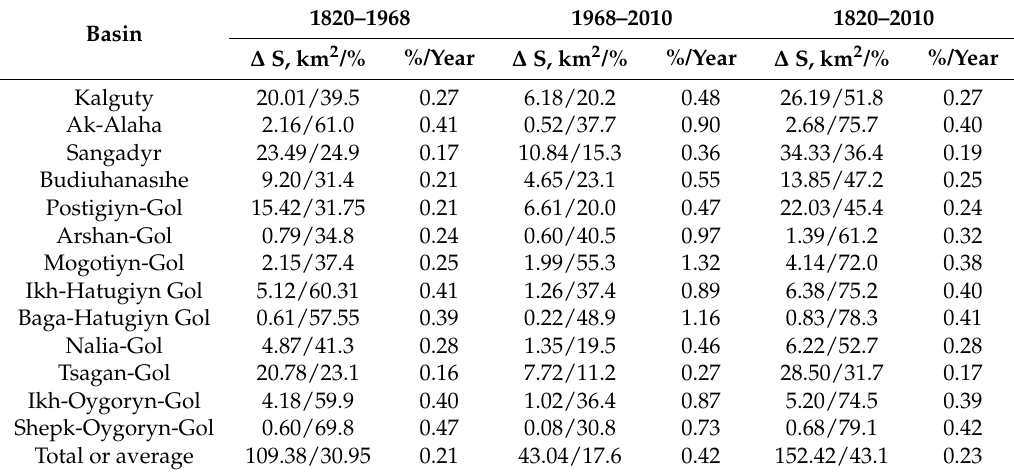
Table 4. Glacial shrinkage in different river basins after the LIA peak.